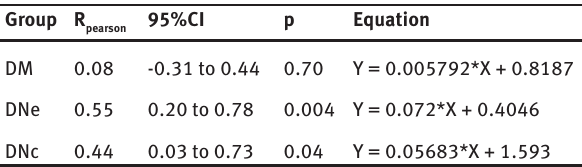
Table 2: The correlation between serological Homocysteine and cystatin C in type 2 diabetes mellitus, early stage diabetic nephropathy and clinical stage diabetic nephropathy group.